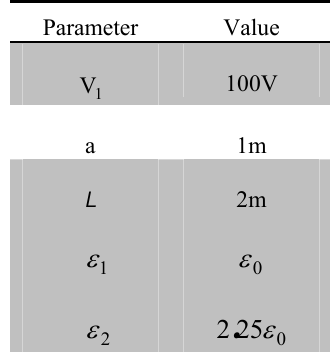
Table 1: Parameters for Case